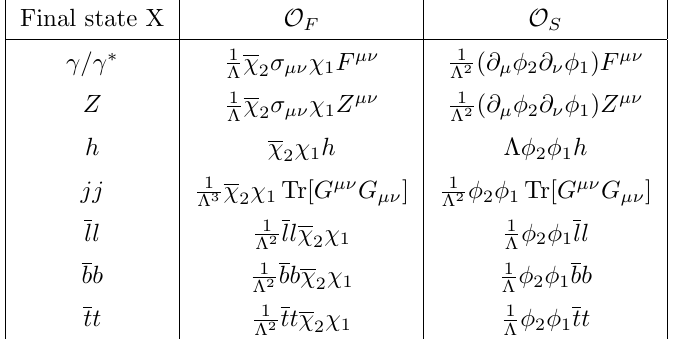
2 ! (cid:31) 1 X for fermionic (middle column)